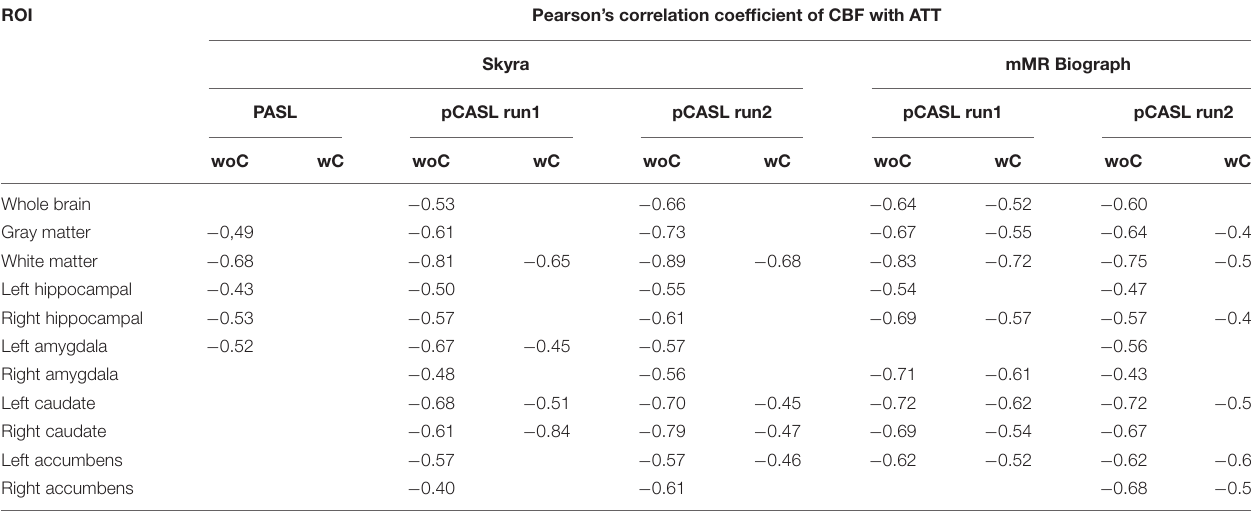
Right amygdala − 0.48 − 0.56 − 0.71 − 0.61 − 0.43 Left caudate − 0.68 − 0.51 − 0.70 − 0.45 Right caudate − 0.61 Left accumbens − 0.57 Right accumbens − 0.40 − 0.61 − 0.68 −